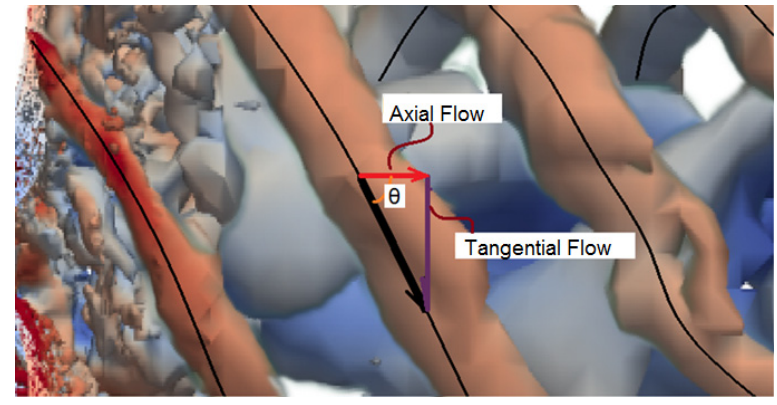
Figure 20. Vortex Detail Structure. Speed 6.5 m/s.